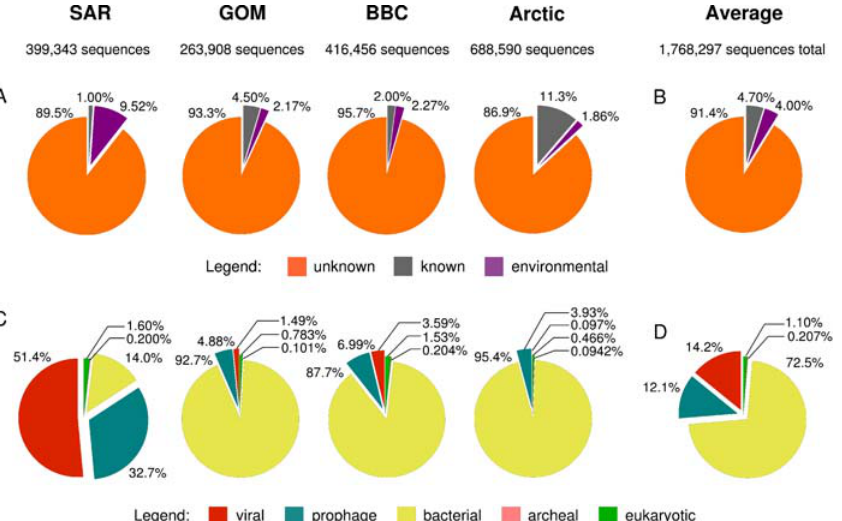
Figure 2. Composition of the Assemblage Genome Sequences as Determined by Similarity to Known DNA and Protein Sequences (A) The percent of ‘‘ known ’’ sequences compared to the SEED and environmental databases. A sequence was considered ‘‘ known ’’ if it had a significant similarity ( E , 10 (cid:1) 5 ) to the SEED, else ‘‘ environmental ’’ if it had a similarity to any environmental database, and else ‘‘ unknown ’’ . (B) Breakdown of the ‘‘ known ’’ sequences into viral (both eukaryotic and bacteriophages), prophage, Bacteria, Archaea, or Eukarya. DOI: